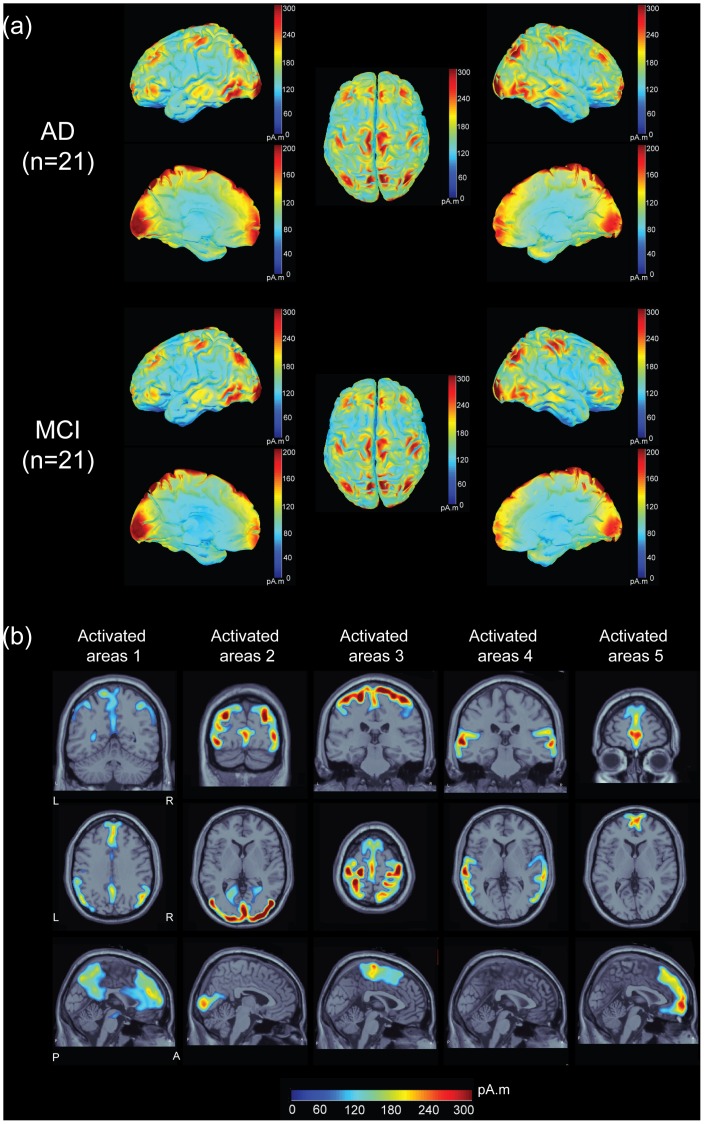
Resting state networks from EEG data.(a) Distributions of averaged cortical activation during an eyes-closed resting-state condition in 21 AD and 21 MCI patients, respectively. (b) 5 activated maps on the sagittal, coronal and axial MR images are shown. The sources values were smoothed after being re-interpolated (the size of the smoothing kernel = 5). The current strength of cortical sources is color coded; large values are represented in red, and small values are in blue.